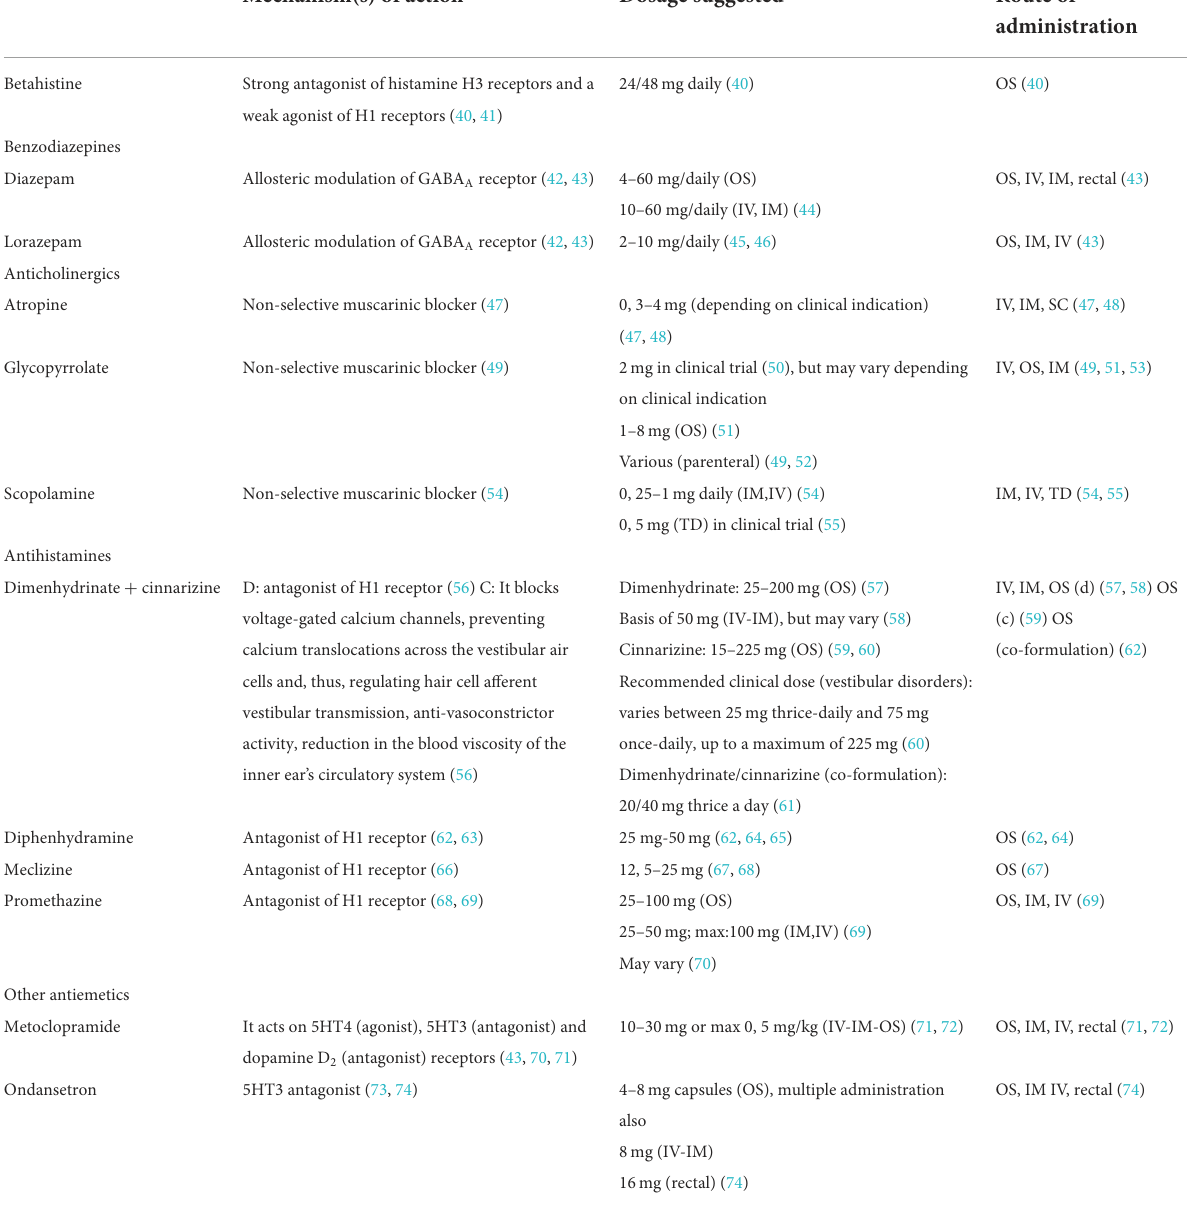
TABLE 1 Mechanism of action and dosage of vestibular neuritis drugs. Mechanism(s) of action Dosage suggested Route of